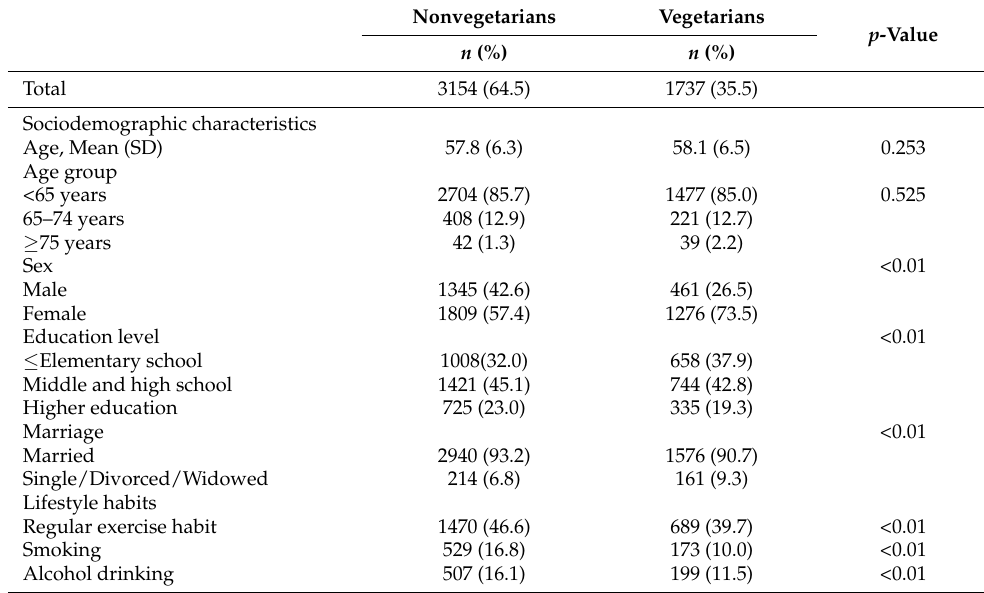
Table 1. Sociodemographic characteristics of vegetarians and nonvegetarians.